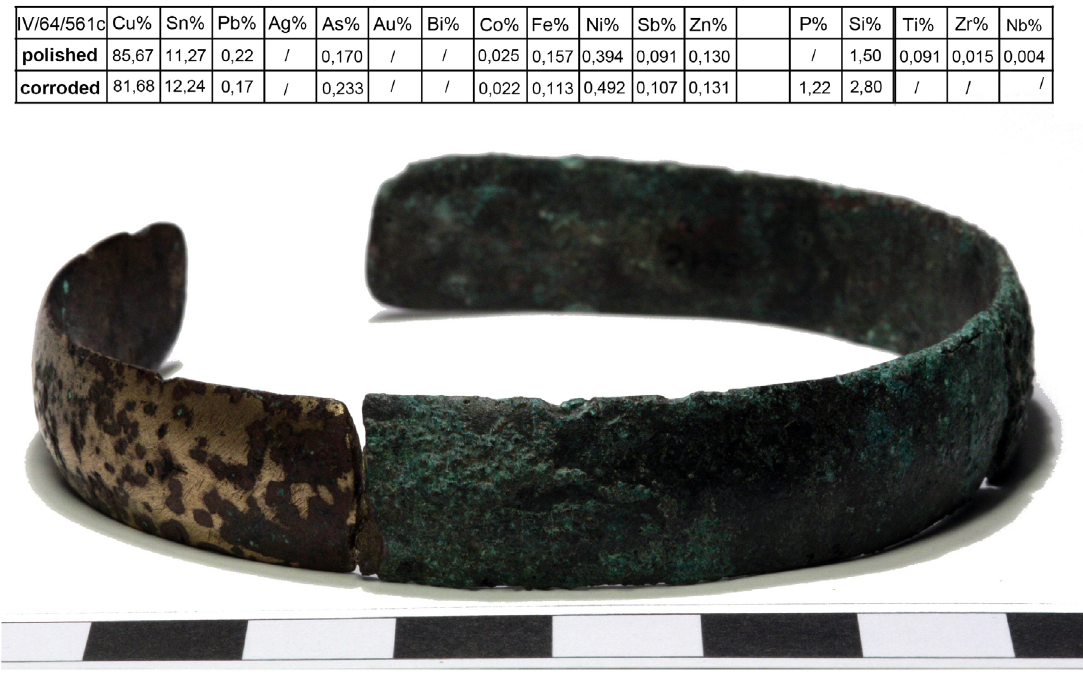
Figure 9. Bracelet from Gielow, Kr. Malchin in Mecklenburg. Using the XRF device, once the polished section and the corroded section of the bracelet were measured (picture: Heide Wrobel